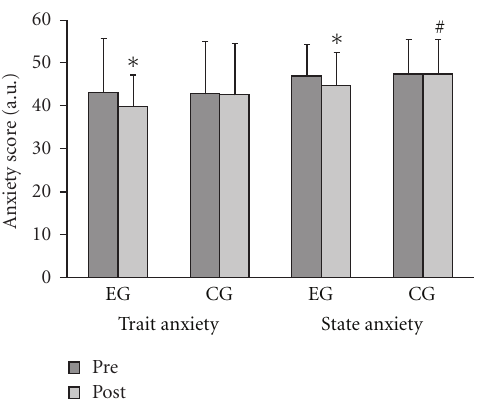
Figure 1: Anxiety pre- and poststrength training using the STAI I and II in the experimental (EG, n = 11) and control (CG, n = 13) groups. ∗ P ≤ 0 . 05 (Wilcoxon Test). Di ff erent from pre in the same group. # P ≤ 0 . 05 (Mann-Whitney Test) Di ff erent from the corresponding measure in EG for STATE